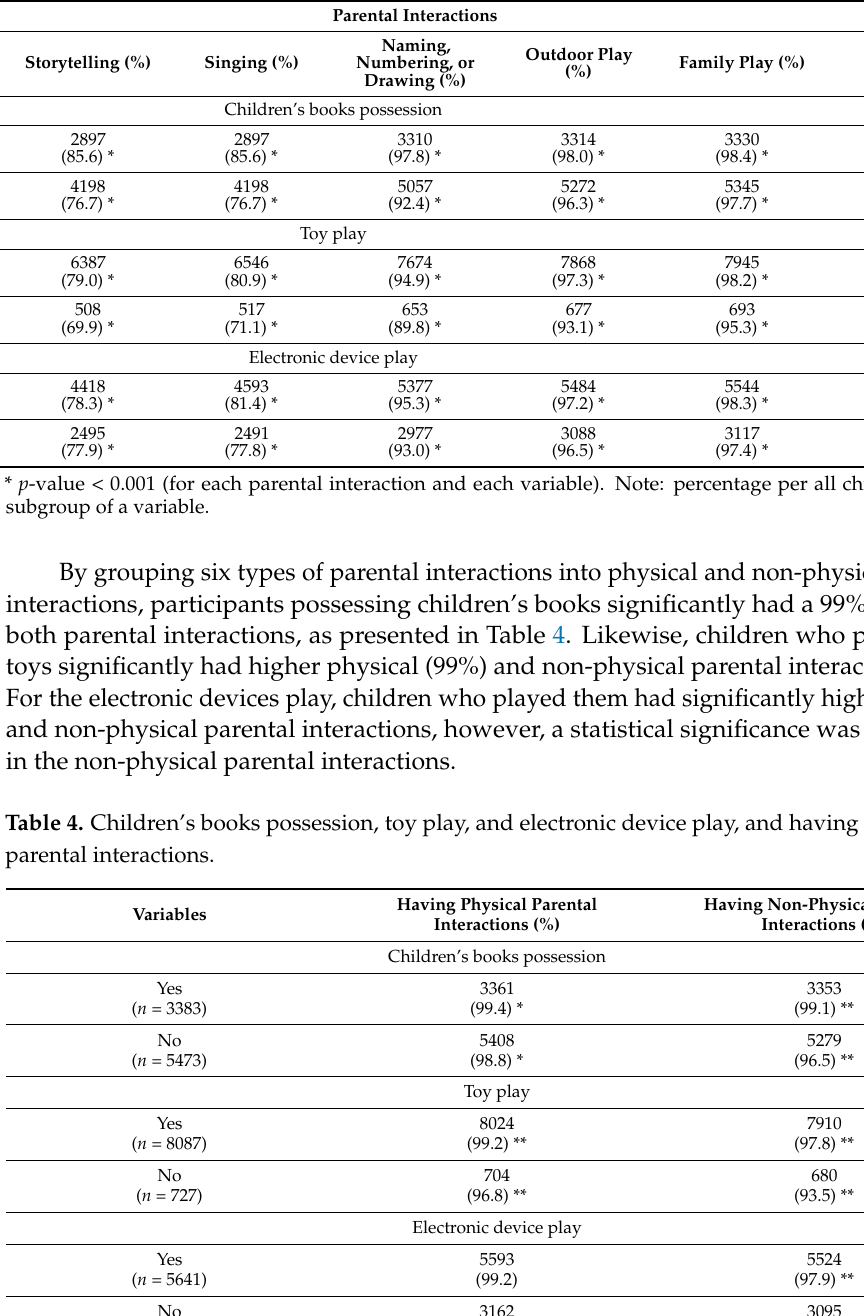
Table 3. Children’s books possession, toy play, electronic device play, and parental interactions.